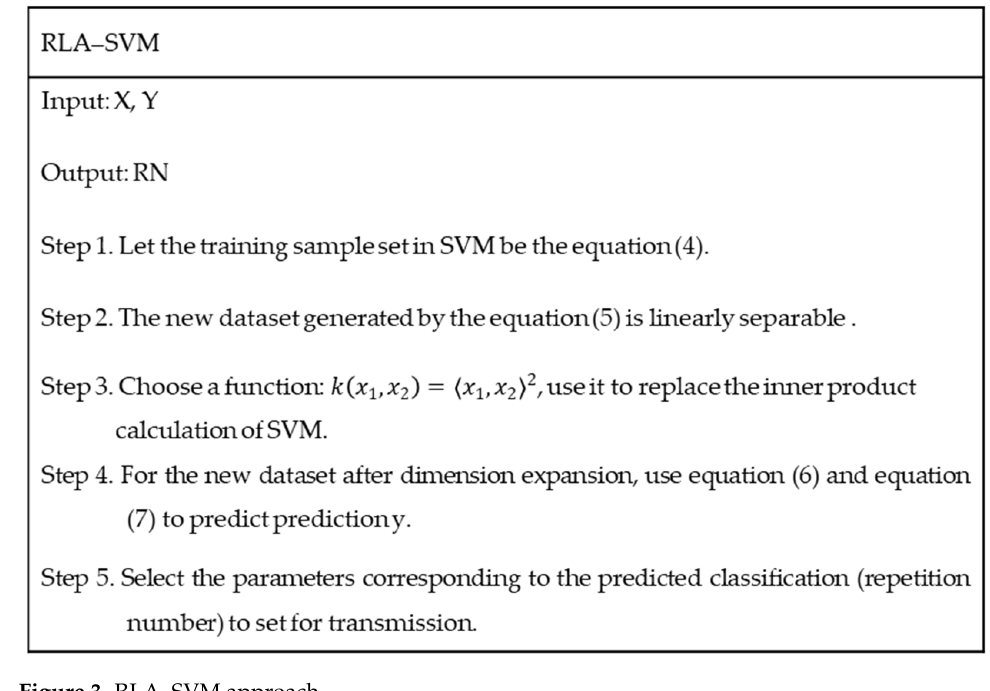
Figure 3. RLA–SVM approach.